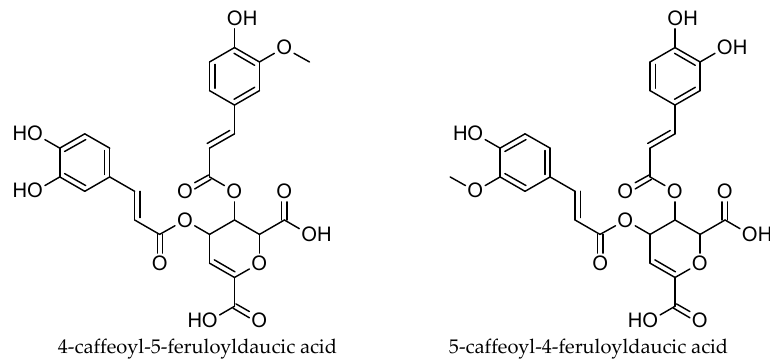
Figure 3. Two possible isomers of caffeoyl-feruloyldaucic acid.